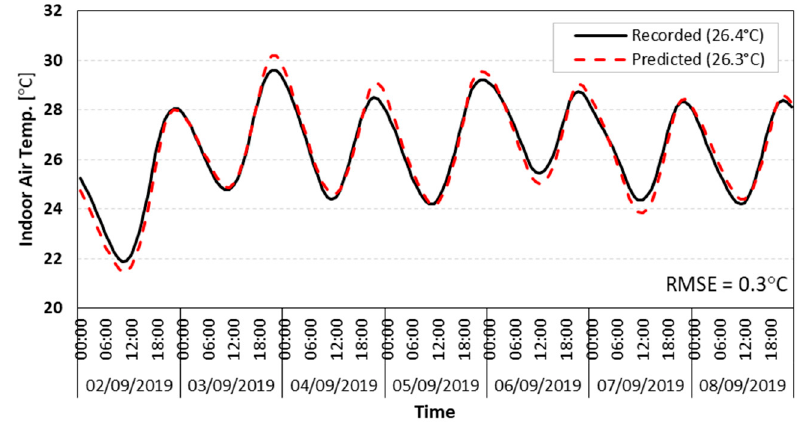
Figure 7. Predicted and measured indoor temperatures in module 1 (reference).